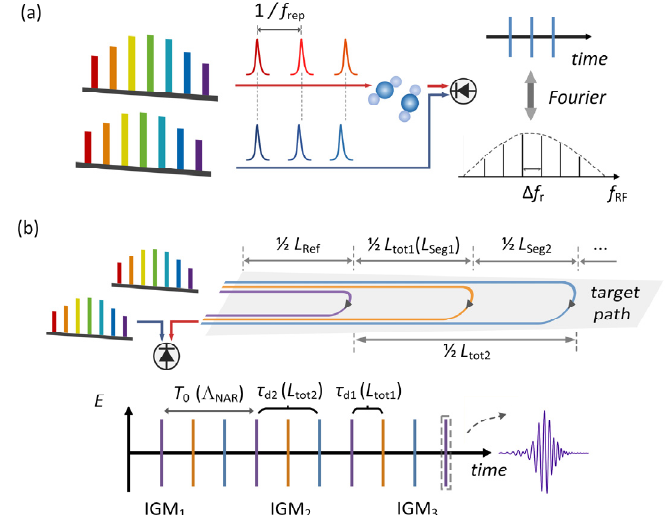
Figure 1. Schematic diagram of dual-comb method and time domain multiplexed dual-comb method.